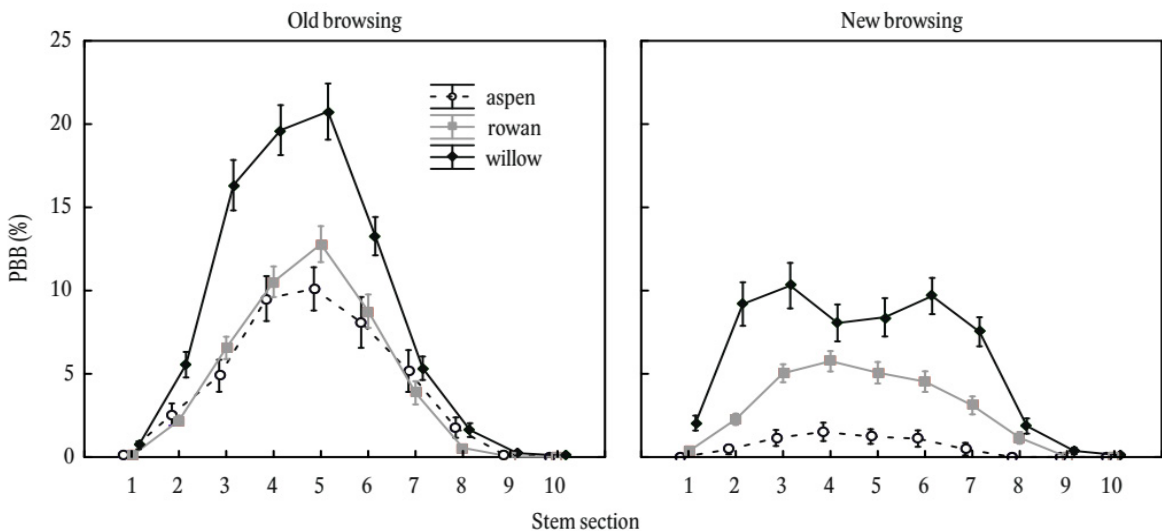
Figure 4. Stem bark browsing on common aspen ( Populus tremula L.), common rowan ( Sorbus aucuparia L.), and goat willow ( Salix caprea L.) considering old (2019 and 2020) and new (2021) wounds by stem section. Stem browsing is expressed on relative basis (i.e., proportion of browsed bark mass to full bark mass potential). The error bars indicate standard errors. The stem sections are coded as 1: 0–25 cm, 2: 26–50 cm, 3: 51–75 cm, 4: 76–100 cm, 5: 101–125 cm, 6: 126–150 cm, 7: 151–175 cm, 8: 176–200 cm, 9: 201–225 cm, and 10: 226–250 cm from the ground